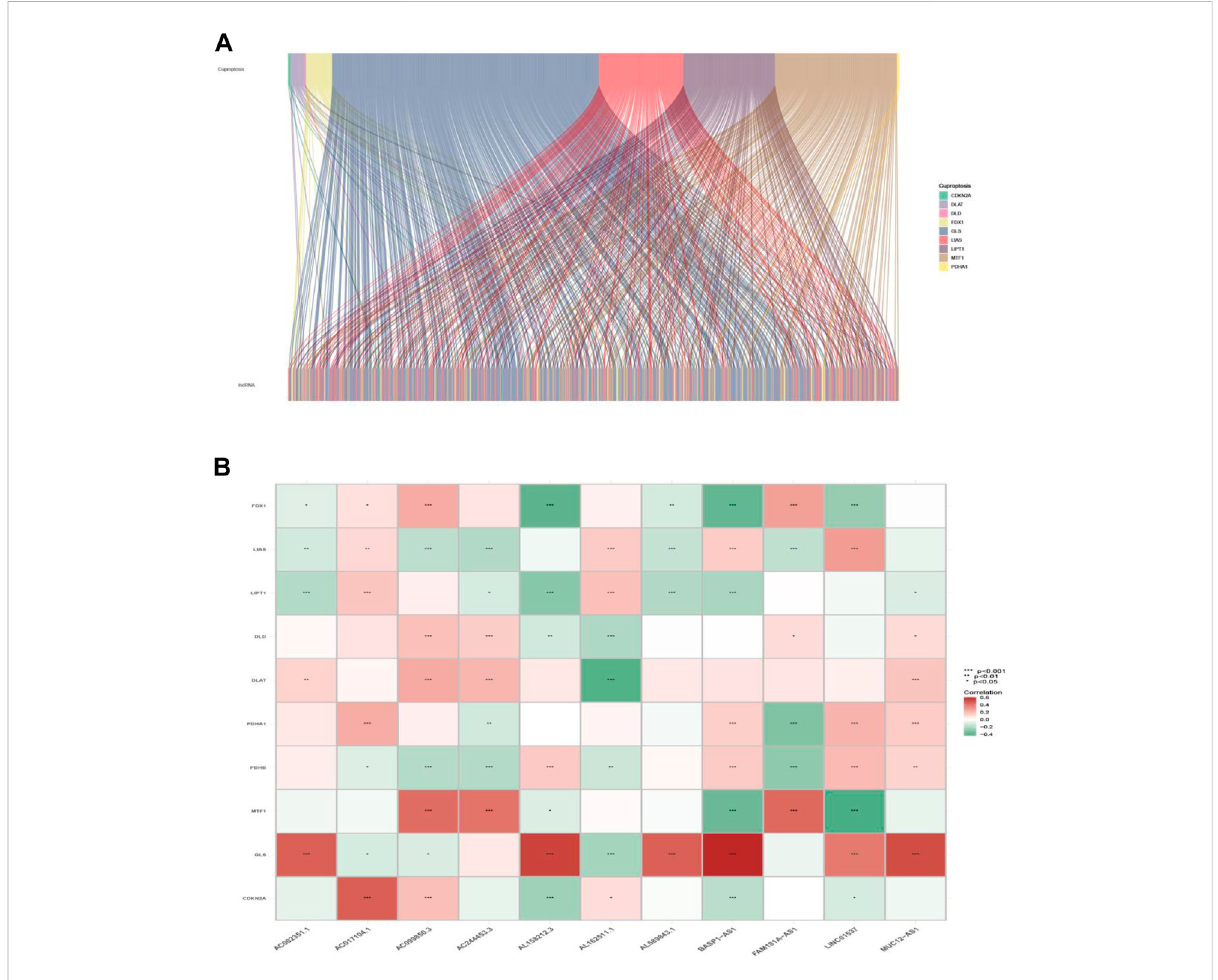
FIGURE 2 Cuproptosis-related gene and lncRNApro fi le in this study. (A) Sankey relation diagram for cuproptosisgenes and lncRNAs. (B) Heatmap for the correlations between cuproptosis genes and